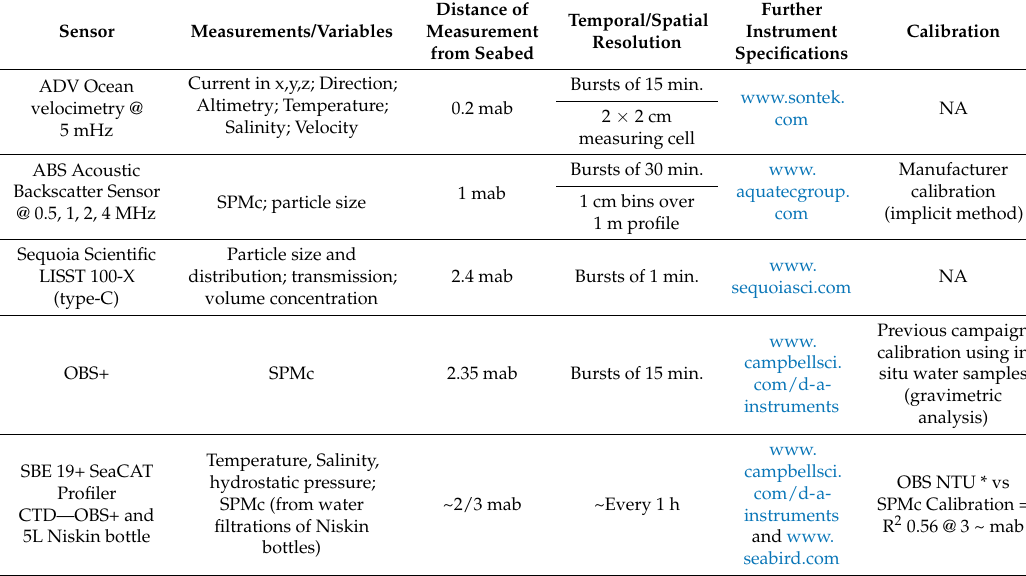
Table 3. Summary of the oceanographic sensors installed on the benthic lander used to quantify the driving processes of variability in the MBES backscatter